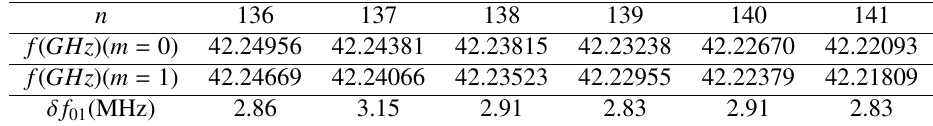
Table 3: Frequency and adjacent frequency o ff set of eigenmode with di ff erent mode number m and n .